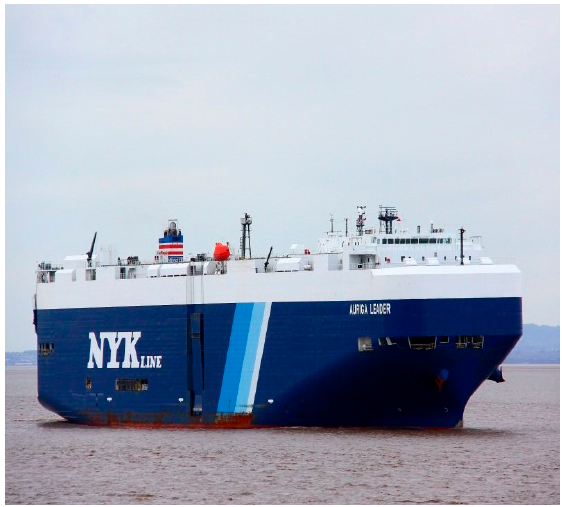
Figure 2. Auriga Leader [44]. Reprint with the written permission from the photographer Tom Anderson 2019.